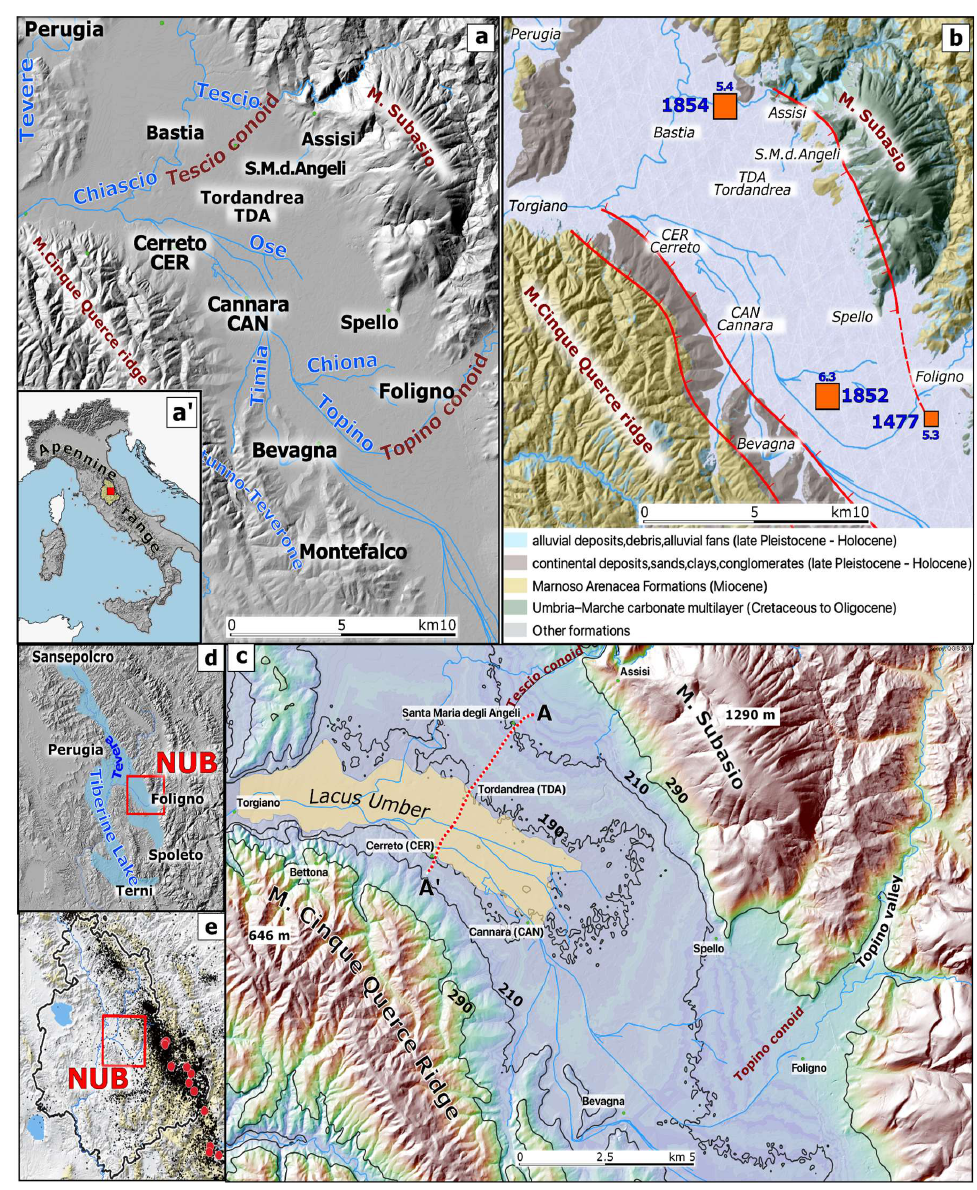
Figure 2. ( a ) The principal towns, mountains and rivers of the NUB. ( a’ ) The Italian peninsula with the Umbria region (light yellow polygon); the red dot locates the NUB. ( b ) Geology map of the NUB area: red lines are the normal fault traces (the vector layers were provided by Regione Umbria WEBGIS service), and the shaded relief in the background is derived from TINIT DTM [29]; toponyms and river vectors were provided by the Italian ISTAT portal (https://www.istat.it, accessed on 30 March 2023). The orange box locates the epicenters of three main historical earthquakes (Rovida et al., 2021) with the associated magnitude and year of occurrence. ( c ) The NUB orography: the black lines are the isolines showing the valley asymmetry and the shape of the alluvial conoids; the light yellow area locates the sector with the valley’s lower elevations, which was occupied by a large lake and marshy area called “Lacus Umber” [30]. The A-A’ red dots locate the topographic and PS velocity profiles of Figure 7. ( d ) The Tevere Valley, along with the northern and southern NUB, formed the Plio-Pleistocene Tiberine Lake (light blue area). ( e ) The Umbria region border and the cloud of small black dots (2.5 < M < 5) and red circles (M ≥ 5.0) are the 1990–2022 seismicity of this sector of the Apennine chain. The coordinate reference system for all the maps in this work is WGS 84/UTM zone